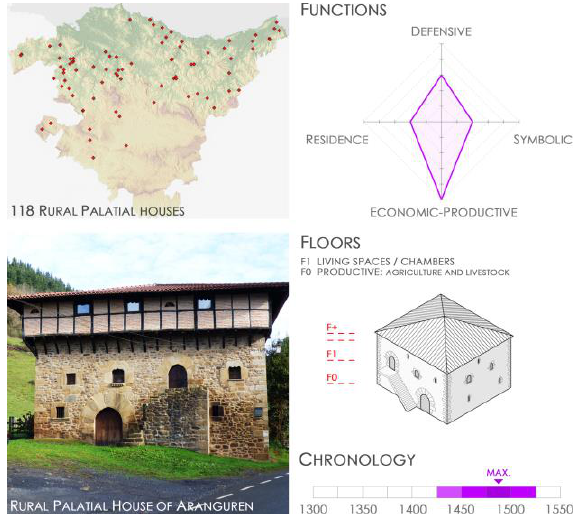
Figure 4. Palatial Rural Houses of the Basque Country.